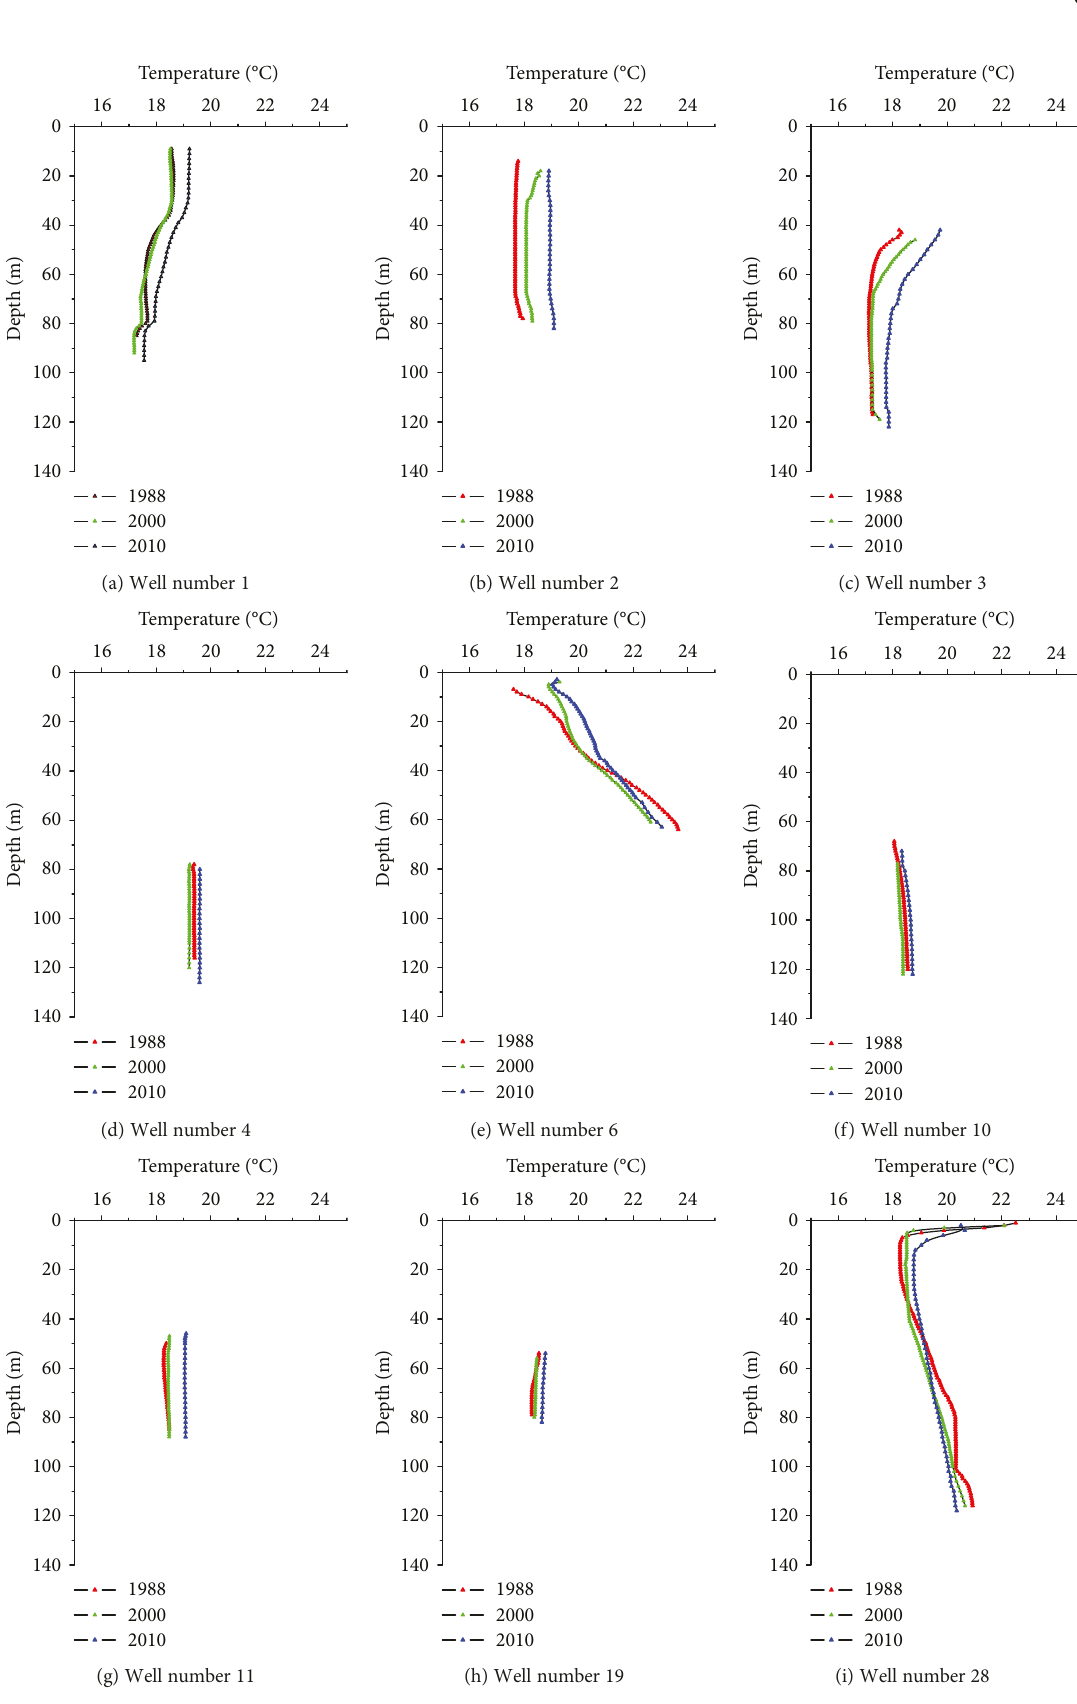
Figure 7: Triple repeated measurements of subsurface temperature-depth pro fi